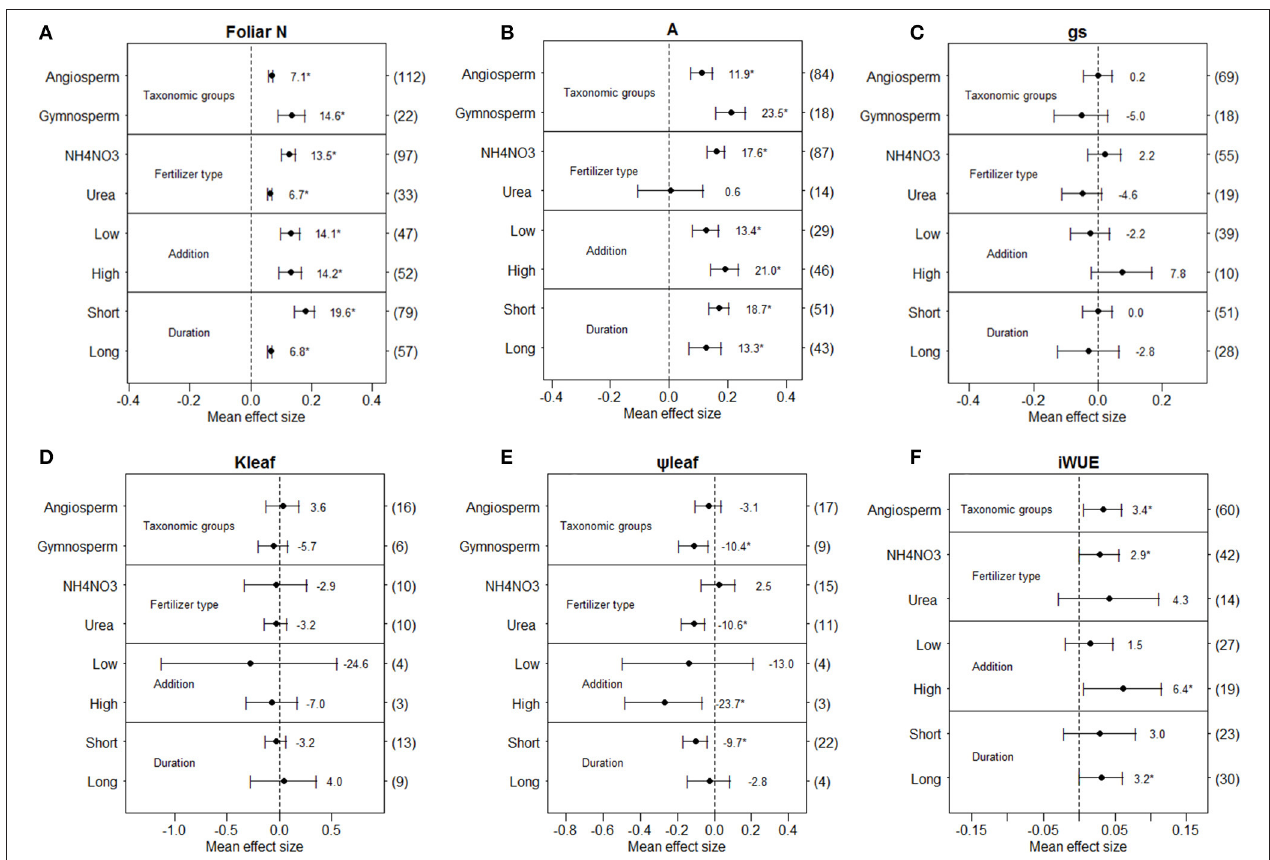
FIGURE 2 | Mean effect sizes of N addition on foliar N content (A) , net photosynthetic rate (B) , stomatal conductance (C) , leaf hydraulic conductance (D) , leaf water potential (E) , and intrinsic water-use efficiency (F) . Error bars indicate 95% confidence intervals (CIs). The number in parentheses represents the sample size for each variables. The percentage of change (%) for each variable is shown next to the point. The variables are categorized into different groups according to plant taxonomic groups, fertilizer type, N-addition levels and treatment